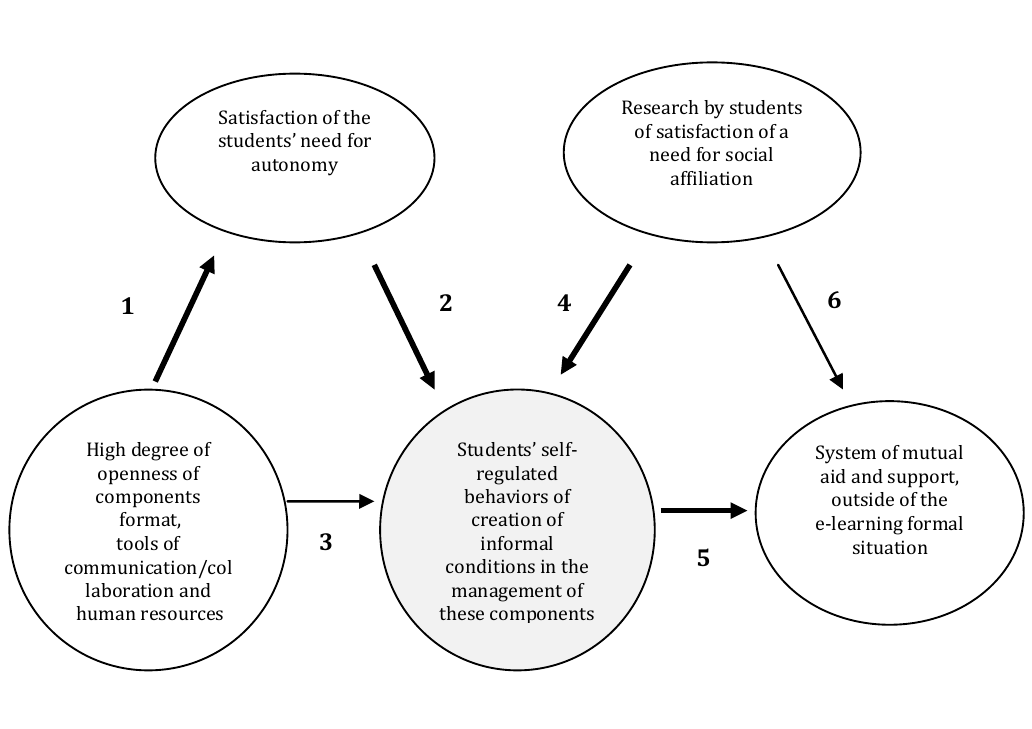
Figure 9 . The two influence processes linked to students’self-regulated behaviors of creation of informal conditions in the management of format, tools of communication and human